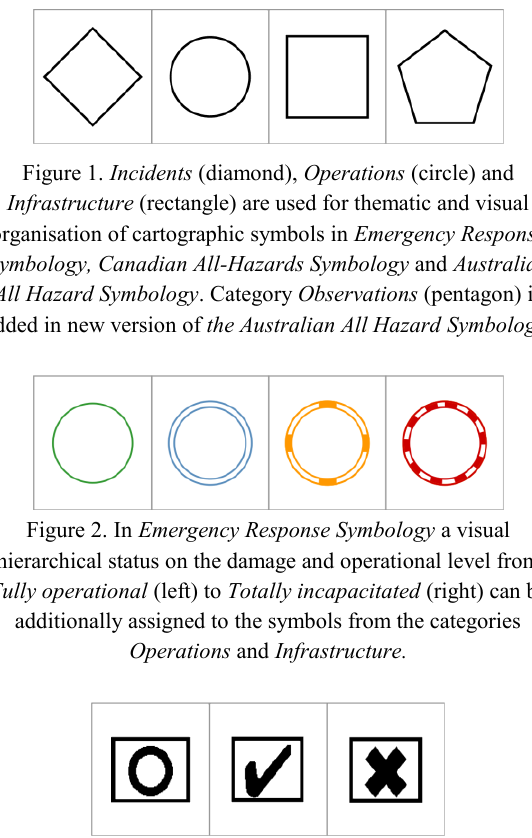
Figure 3. Ordered property for representing the status of the asset Potentially Defendable (circle), Defendable (checkmark) and Not Defendable (cross) within the symbol frame is available in new version of the Australian All Hazard Symbology.